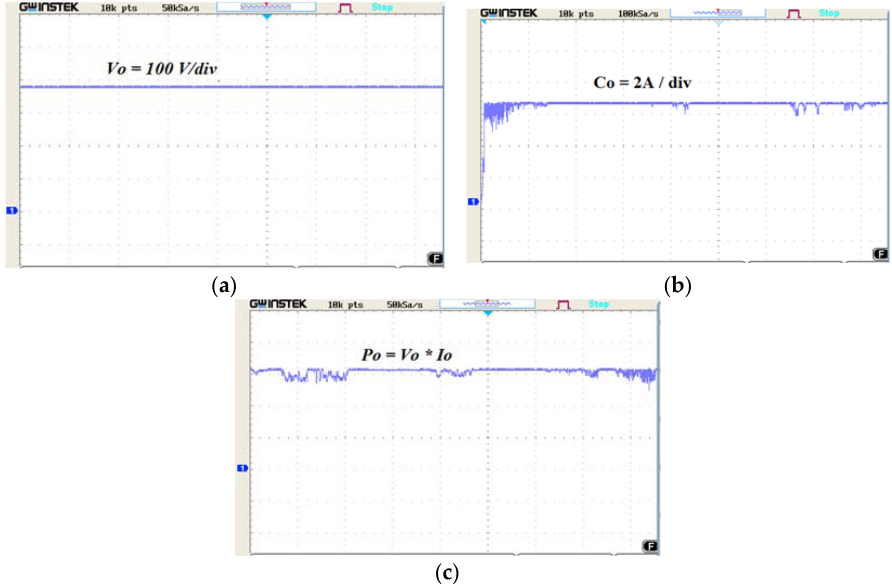
Figure 13. Hardware setup of the Proposed converter with RBFN based MPPT control strategy.